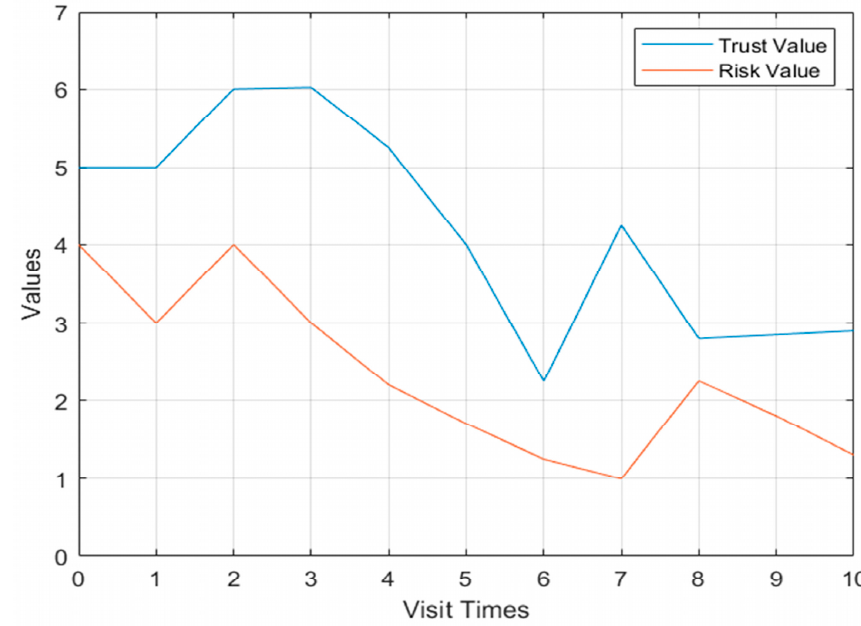
Figure 5. The u_2 behavior risk value and trust change curve Model 2.